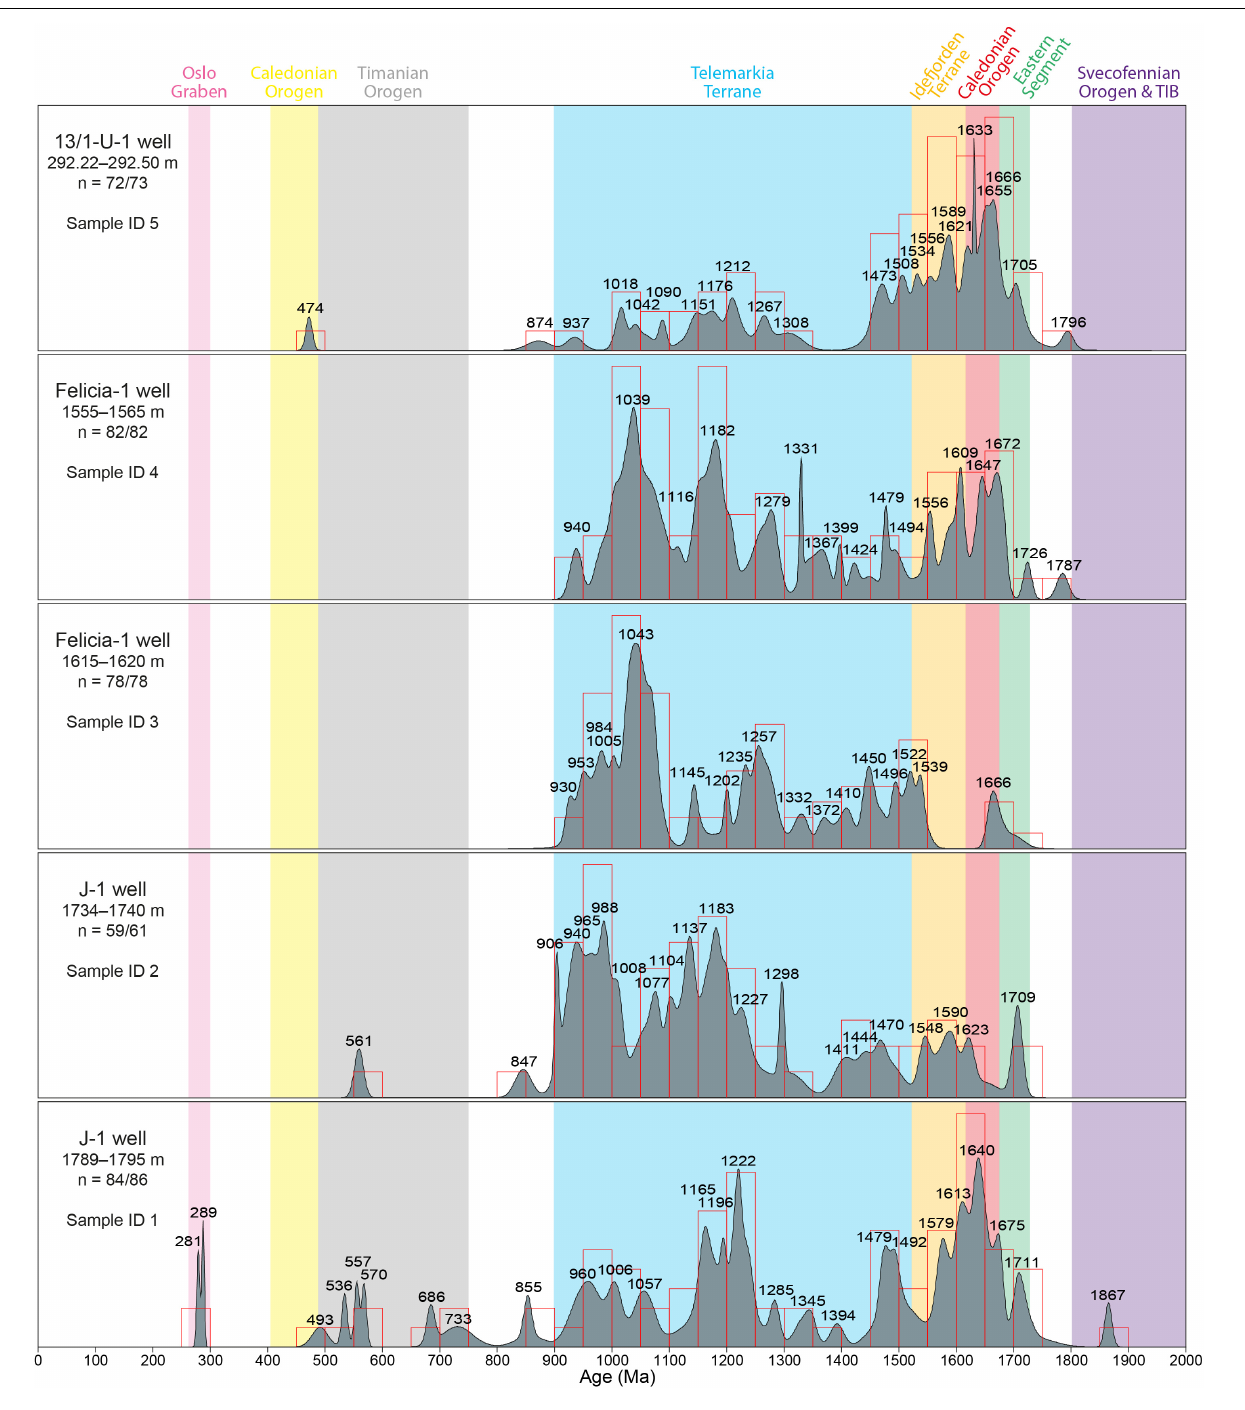
FIGURE 11 | U-Pb ages of zircon grains from the Gassum Formation in the Skagerrak plotted as probability density distributions and histograms. The number of employed concordant ages (discordance < 10%) out of the total number of measured ages is given by “n.” See Figure 4 for sampling positions in the wells and Figure 12 for location of the wells and basement